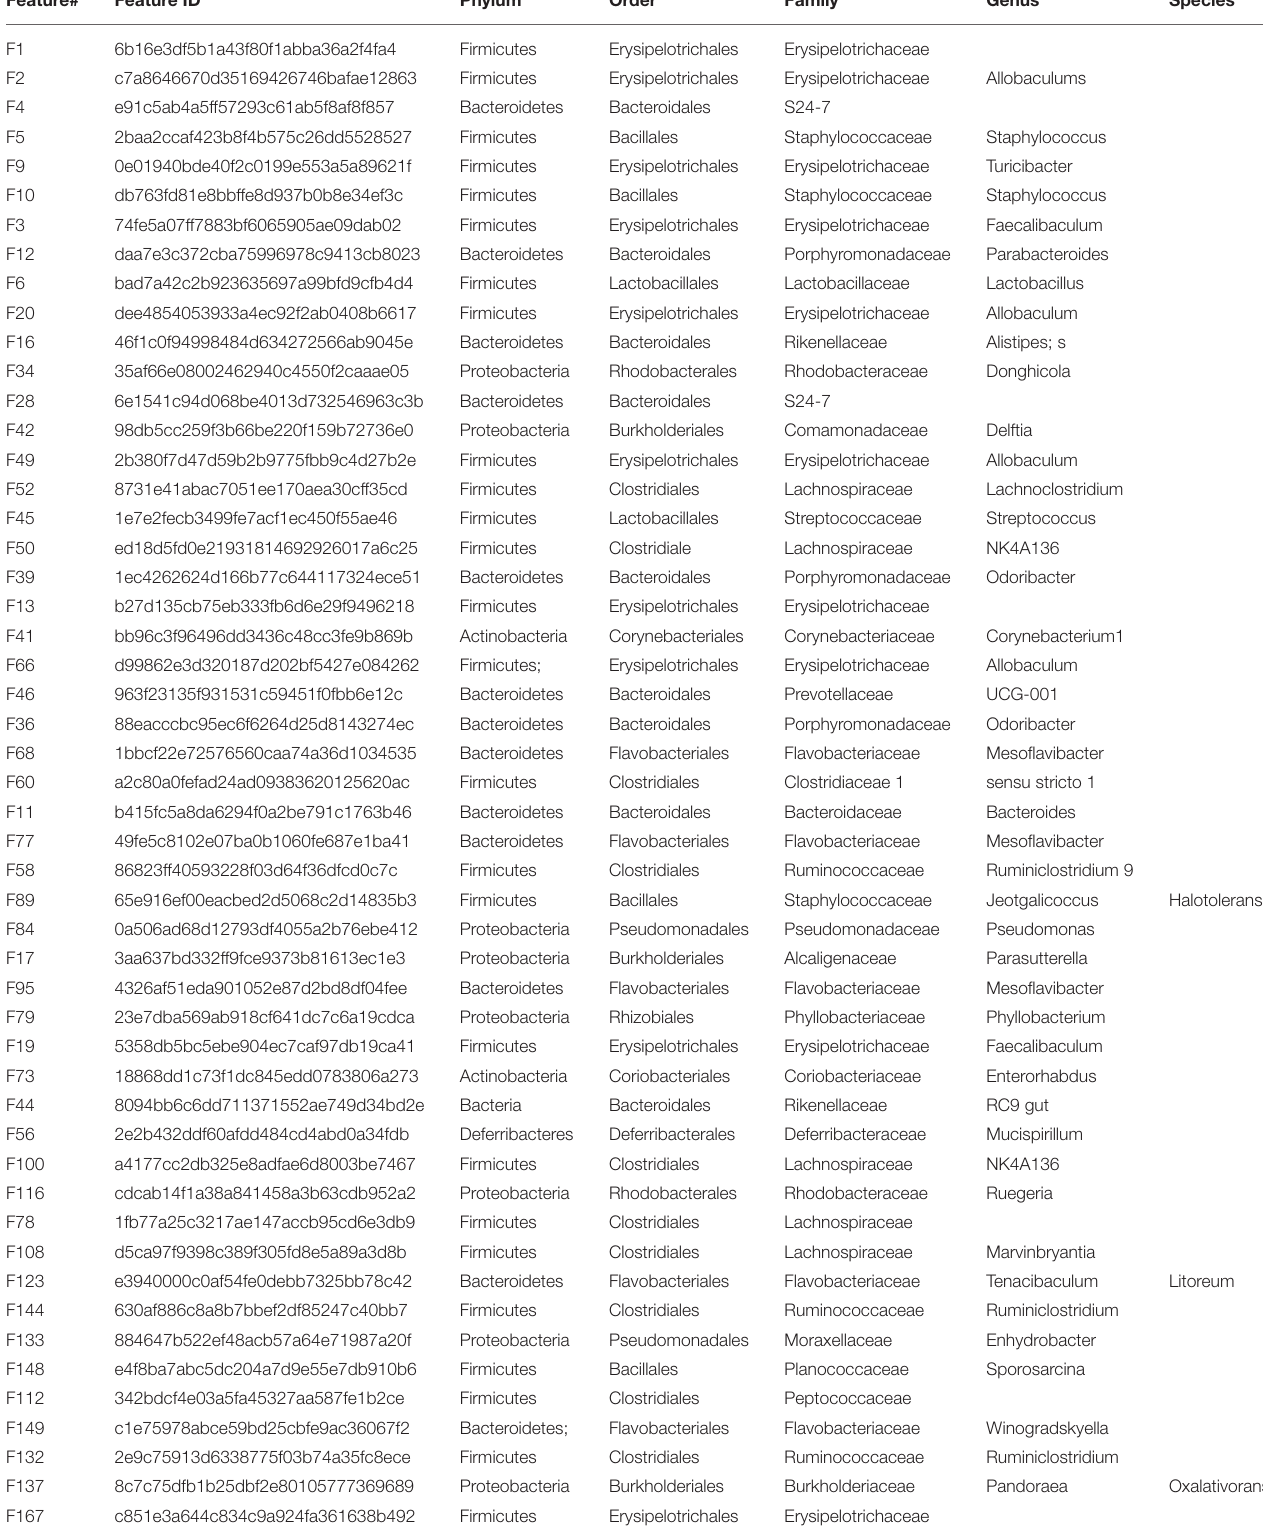
TABLE 1 | The mice core gut